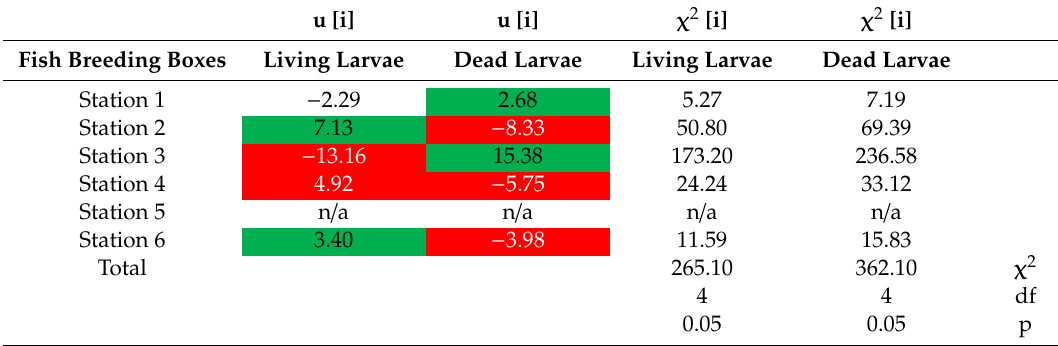
Table 4. Test of the uniform distribution of the living and dead larvae of the five investigative spots (z-test, p = 0.01). Green area: significantly typical (specifically “many”) living larvae; red area: significantly atypical (specifically “little”) living larvae; white area: no significance; n / a: not available. u [i] u [i] χ 2 [i] χ 2 [i] Fish Breeding Boxes Living Larvae Dead Larvae Living Larvae Dead Larvae Station 1 − 2.29 2.68 7.19 Station 2 69.39 236.58 24.24 33.12 n / a 15.83 265.10